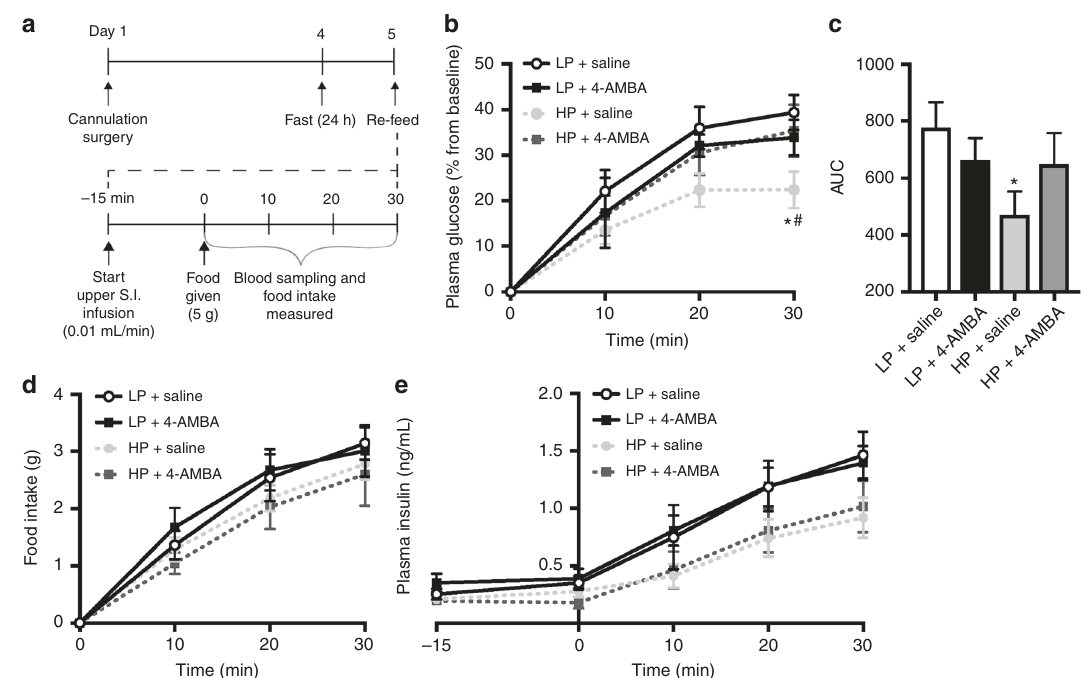
Fig. 4 Upper small intestinal PepT1-mediated protein sensing is physiologically relevant during refeeding in healthy rats. Conscious, unrestrained healthy rats underwent a fasting – refeeding protocol in which a low protein (LP) or casein-enriched high protein (HP) diet was offered ad libitum as outlined in a . Percentage of change in plasma glucose levels and integrated area under the curve ( b , c ), cumulative food intake ( d ), and plasma insulin levels ( e ) were monitored in rats that received LP or HP chow with an upper small intestinal (S.I.) infusion of saline (LP: n = 7, HP: n = 9) or 4-AMBA (LP: n = 6, HP: n = 9). Values are presented as mean ± s.e.m., where asterisk (*) represents p < 0.05 compared to LP saline and hash ( # ) represents p < 0.05 compared to HP + 4-AMBA. For the analysis of a single time point, ANOVA with Tukey post-hoc test was used to determine statistical signi fi